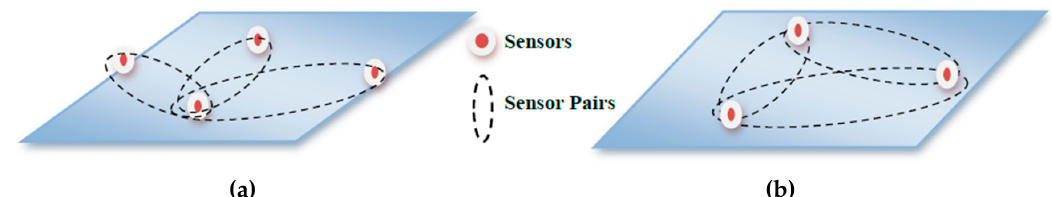
Figure 1. Time Difference of Arrival (TDOA) sensor pairing techniques ( a ) Centralized Sensor Pairing (CSP); ( b ) Decentralized Sensor Pairing (DSP).